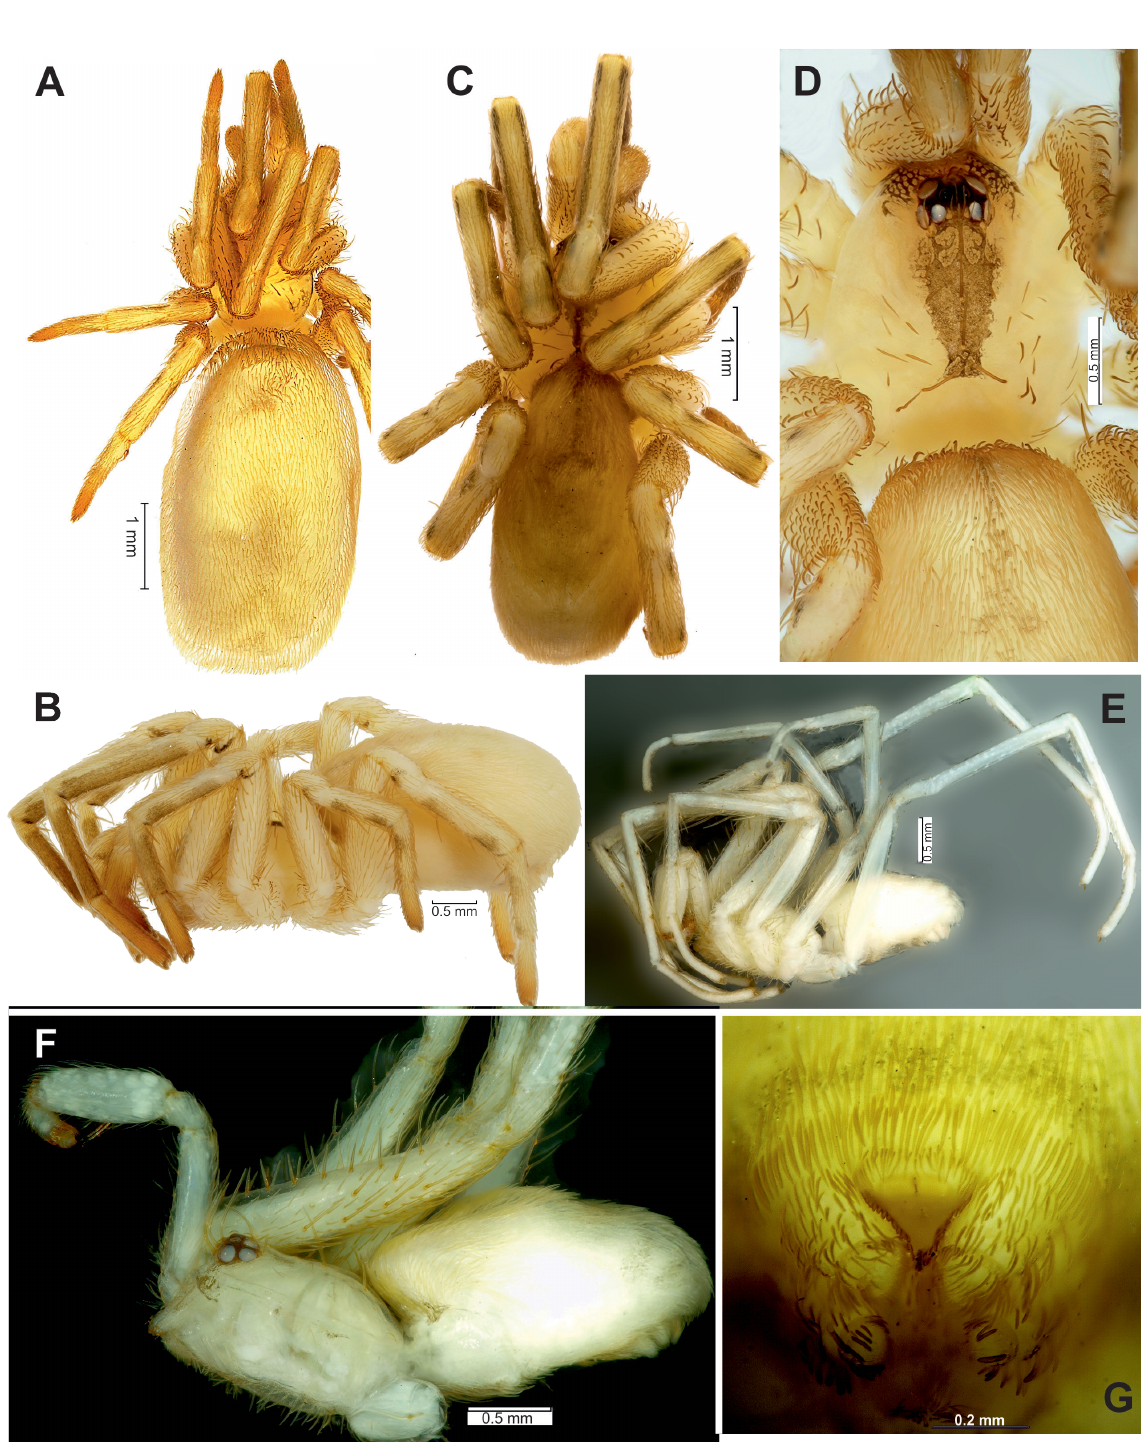
Fig. 19. Somatic characters of Zaitunia logunovi sp. nov., paratypes, ♀♀ ( A – D , G ), and holotype ( E ) and paratype ( F ), ♂♂. — A , C . Habitus, dorsal. B , E–F . Same, lateral. D . Prosoma, dorsal. G . Spinnerets, ventral. Scale bars: a, C = 1.0 mm; B, D–F = 0.5 mm; G = 0.2